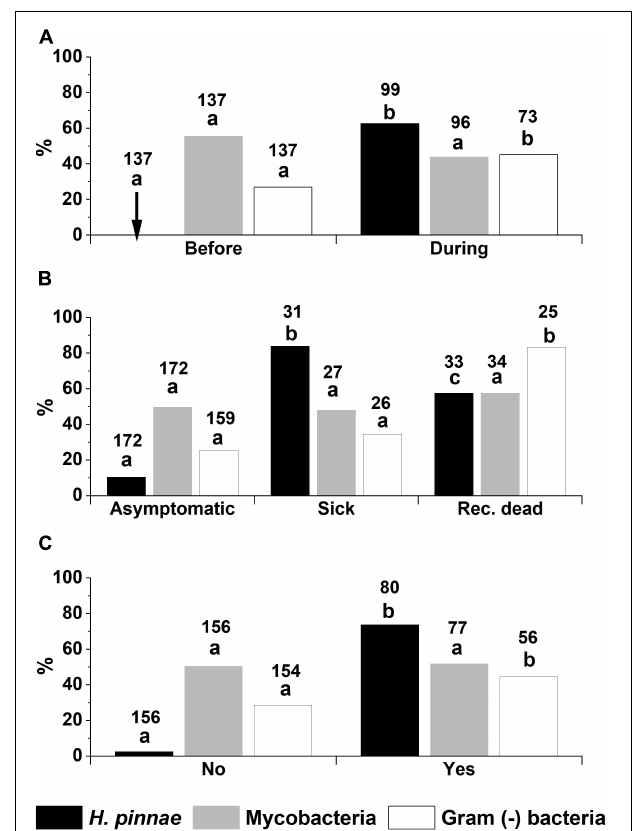
FIGURE 5 | Percentages of infection with Haplosporidium pinnae , mycobacteria and Gram ( − ) bacteria, diagnosed with histology, in fan mussels classified according to (A) the period of sampling (either before or during the MME), (B) the fan mussel health condition (asymptomatic, sick or recently dead), and (C) the background of high mortality at sampling location (either yes or no). Different letters above bars denote significant differences between fan mussel classes for each pathogen. The arrow in the top graph points out 0% cases of infection with H. pinnae . The numbers above bars correspond to the number of fan mussels analysed in each